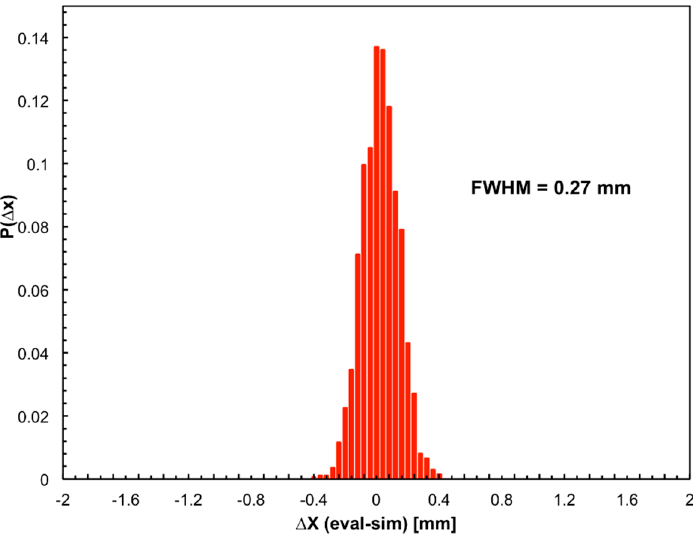
Figure 22. Simulation of the distribution of the difference ∆ X between the position reconstructed on the focal plane (eval) and the generated one (sim). The expected FWHM resolution is about 0.27 mm.